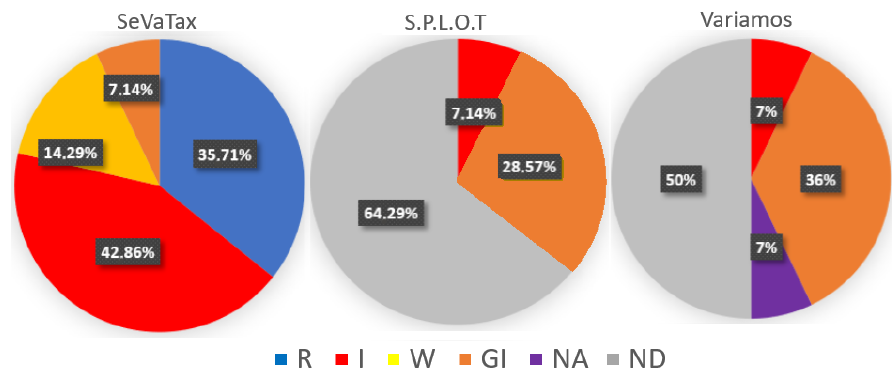
Figure 21. Coverage percentage for each validation scenario according to the three